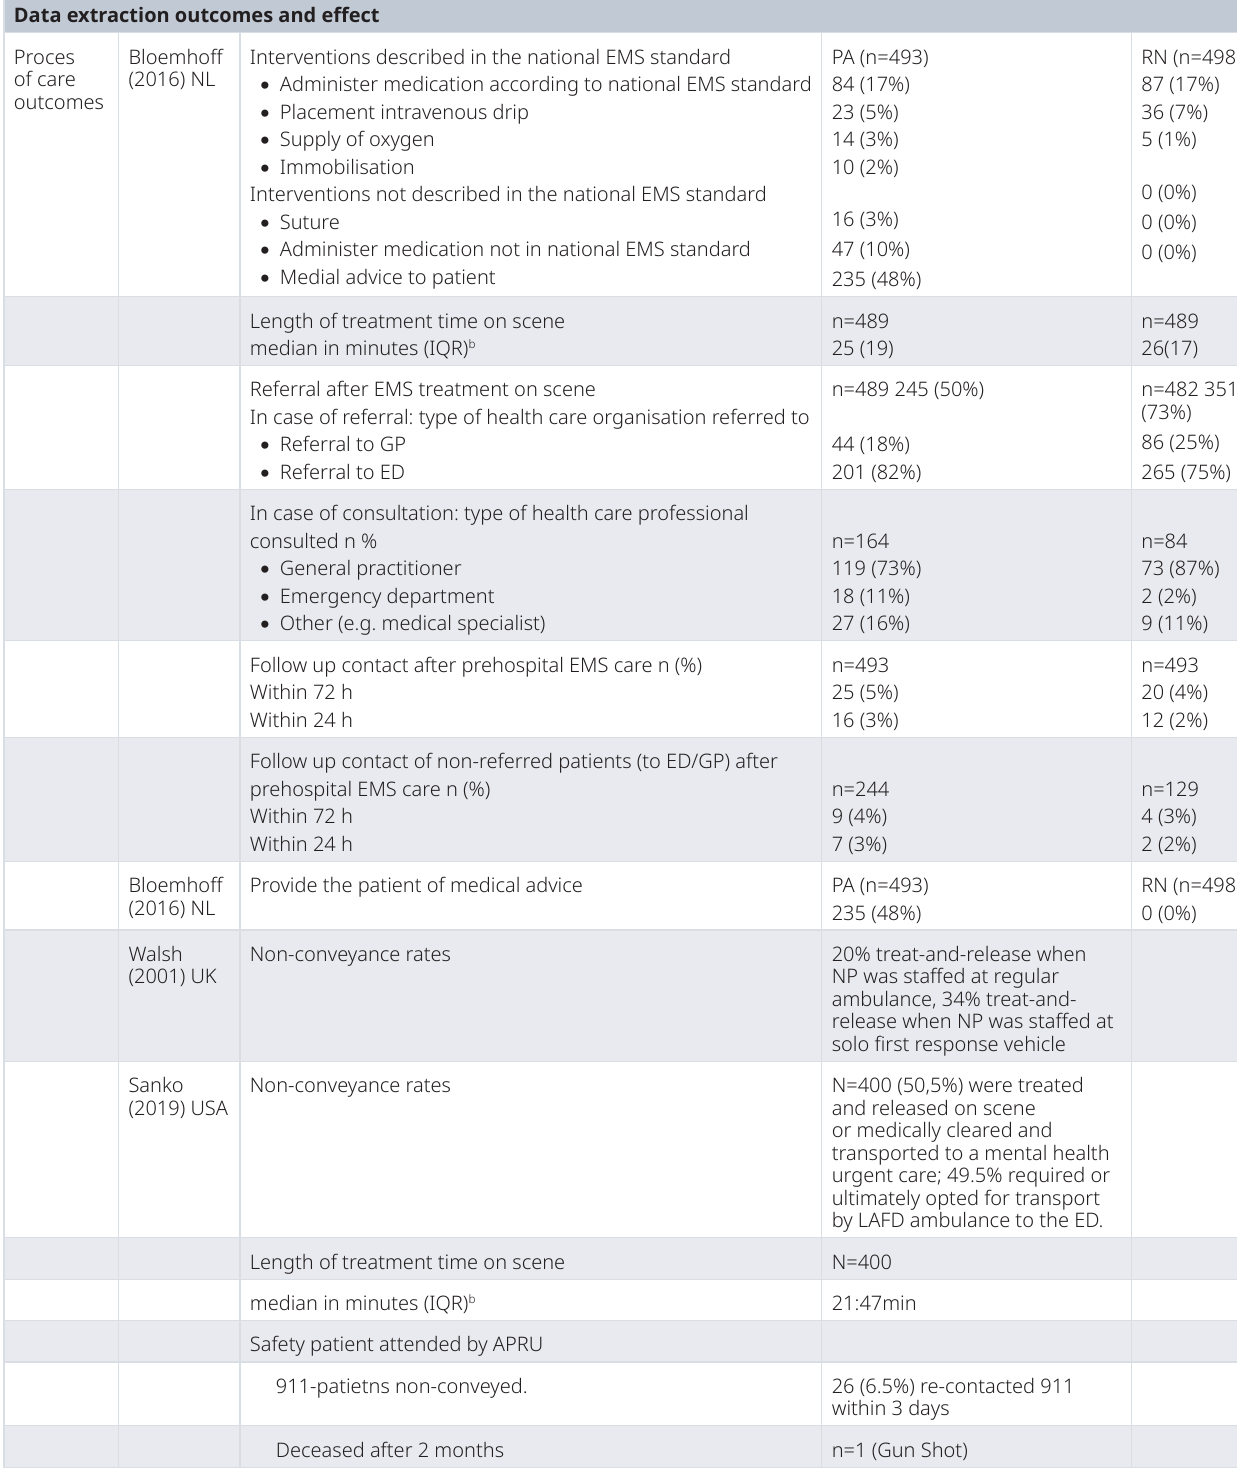
Table 3. Process of care and resource use